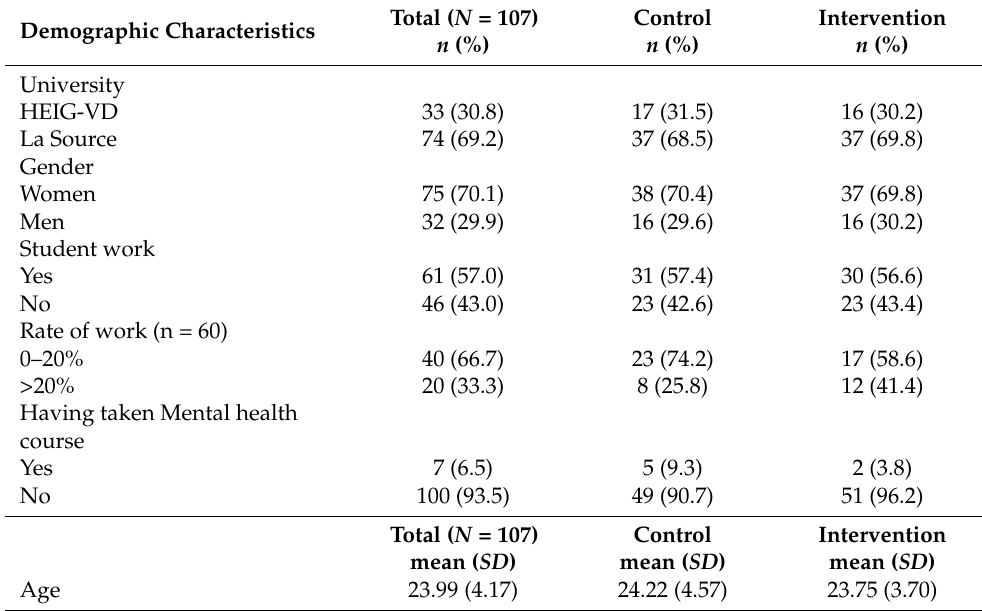
Table 1. Participant characteristics at baseline (T0).